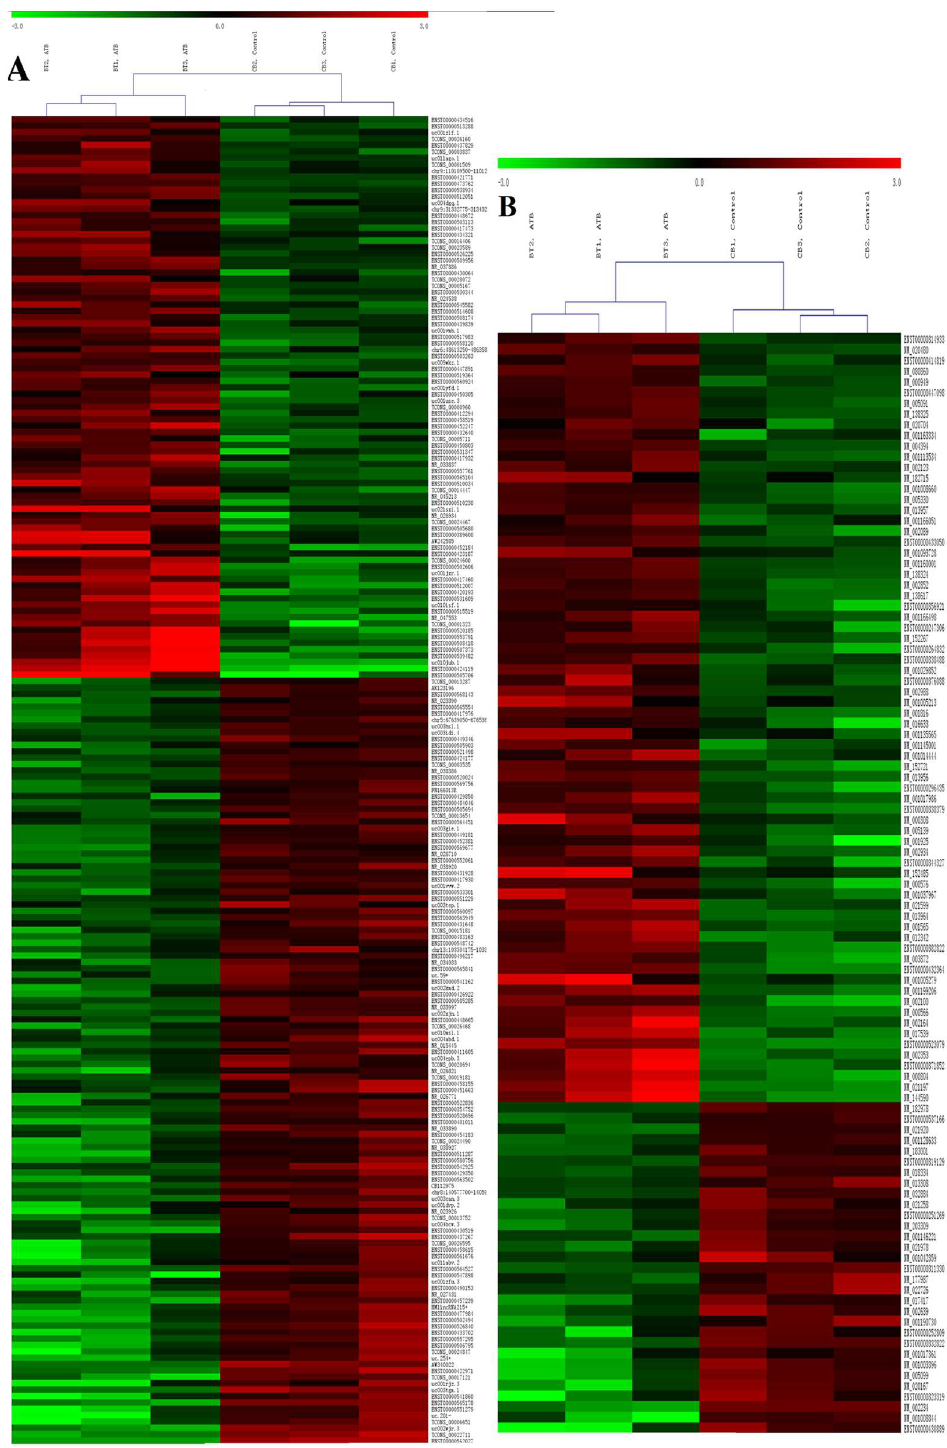
Fig 1. Differentially expressedlncRNAs (A) and mRNAs(B) between ATB group and control group. Red indicatedhigh relative expressionand green indicatedlow relative expression. LncRNA or mRNA with expressionfold change > 3 and with FDR adjusted P value < 0.05 was consideredstatistically significant.ATB group: BT1, BT2, BT3; Controlgroup: CB1, CB2, CB3.